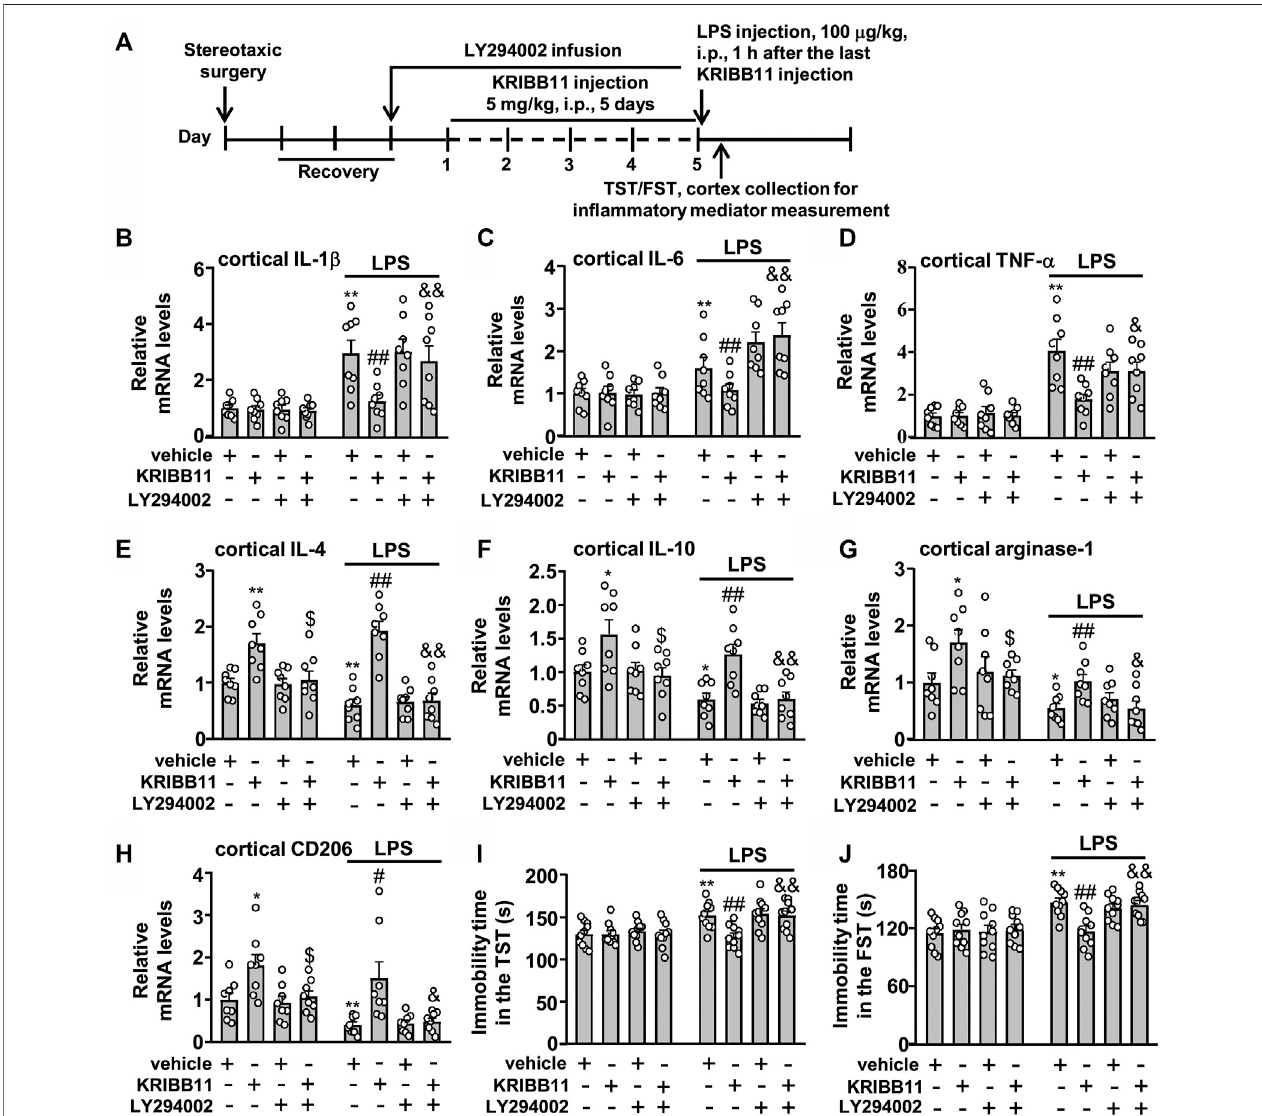
FIGURE9 | LY294002 infusion abrogatesthe preventive effect of KRIBB11 on LPS-induced neuroin fl ammatoryresponsesand depression-like behaviors in mice. (A) Time-lineshowingtheinvestigationoftheeffectofintracerebroventricularLY294002infusiononthepreventiveeffectofKRIBB11onLPS-inducedneuroin fl ammatory responses and depression-like behaviors. (B ‒ D) Quantitative analysis showed that intracerebroventricularly LY294002 infusion abrogated the preventive effect of KRIBB11 on LPS-induced increases in the expression levels of IL-1 β (B) , IL-6 (C) , and TNF- α (D) mRNA in the dorsolateral prefrontal cortex in mice ( n = 8, ** p < 0.01 vs. vehicle, ## p < 0.01 vs. vehicle + LPS, & p < 0.05 or && p < 0.01 vs. KRIBB11 + LPS). (E ‒ H) Quantitative analysis showed the abrogation effect of intracerebroventricular LY294002 infusion on KRIBB11-induced increases in the expression levels of IL-4 (E) , IL-10 (F) , arginase-1 (G) , and CD206 (H) mRNA in the dorsolateral prefrontal cortex inmice treated with or without LPS ( n =8, * p < 0.05 or ** p < 0.01vs. vehicle; $ p < 0.05vs. KRIBB11; # p < 0.05 or ## p < 0.01 vs. vehicle+ LPS; & p < 0.05 or && p < 0.01 vs. KRIBB11 + LPS). (I,J) Quantitative analysis showed that intracerebroventricular LY294002 infusion abrogated the preventive effect of KRIBB11 on LPS-induced increases in the immobility tine in the TST (I) and FST (J) in mice ( n = 10, ** p < 0.01 vs. vehicle, ## p < 0.01 vs. vehicle + LPS, && p < 0.01 vs. KRIBB11 + LPS). Data are shown as mean ± SEM.